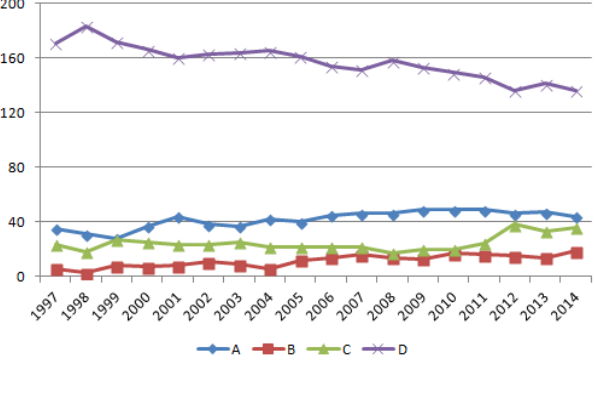
Figure 7: Trends in Number of Products Groups A, B, C and D of Vietnam, 1997-2014